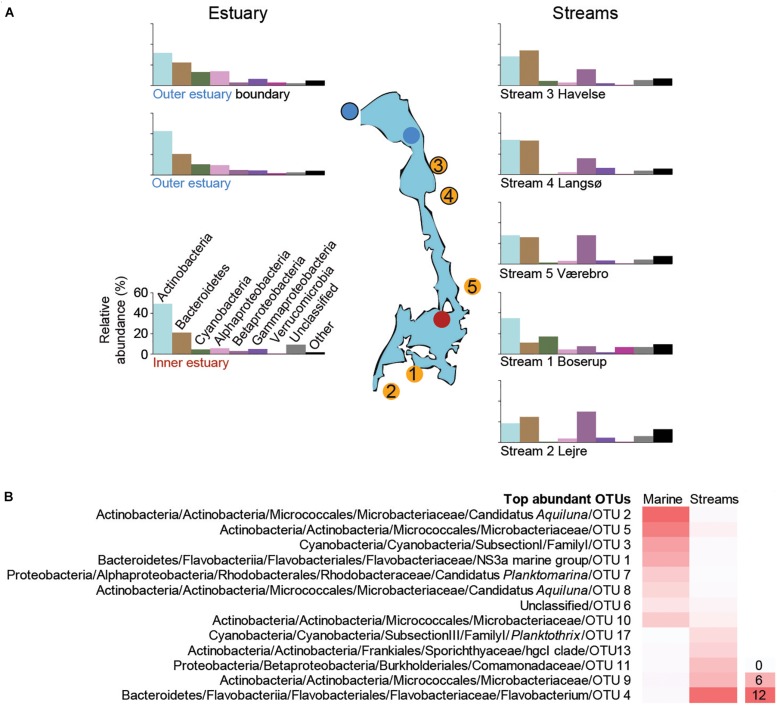
(A) The most abundant taxonomic groups (phyla and Proteobacteria classes) based on the 16S rRNA gene data. Bars are averages from each sampling site over the time series (1 m depth data were used for the marine stations). Data from individual samples from all time points are shown in Supplementary Figures S2 (marine), S4 (streams). The y-axis scale is the same for all bar charts and is shown next to the lower left bar chart. (B) Heatmap of the most abundant OTUs (>0.2% average between aquatic systems) that were present in both marine and stream stations. For each OTU the lowest taxonomic classification is shown followed by the unique OTU number, while the color gradient shows the average relative abundance (%) for all marine or stream stations.